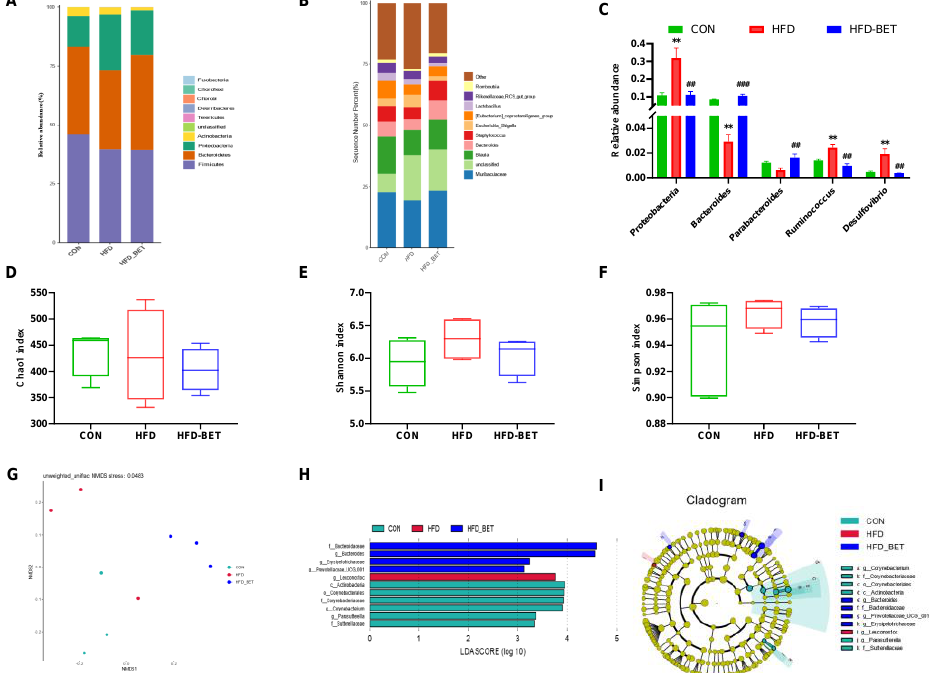
Figure 4. Effects of maternal betaine intake on gut microbiota in offspring mice. ( A ) Taxonomic composition distribution at the phylum level; ( B , C ) taxonomic composition distribution at the genus level; ( D – F ) alpha diversity analysis; ( G ) Non-metric dimensional scaling (NMDS) analysis; ( H , I ) linear discriminant analysis effect size (LEfSe) analysis, and the linear discriminant analysis (LDA) score using a threshold score larger than 2.0. Data are presented as the means ± SEM. ** p < 0.01 for the HFD group vs. the CON group; ## p < 0.01 and ### p < 0.001 for the HFD-BET group vs. the HFD group. Abbreviation: CON group, control diet group; HFD group, high-fat diet group; HFD-BET group, high-fat diet + 1% betaine group.